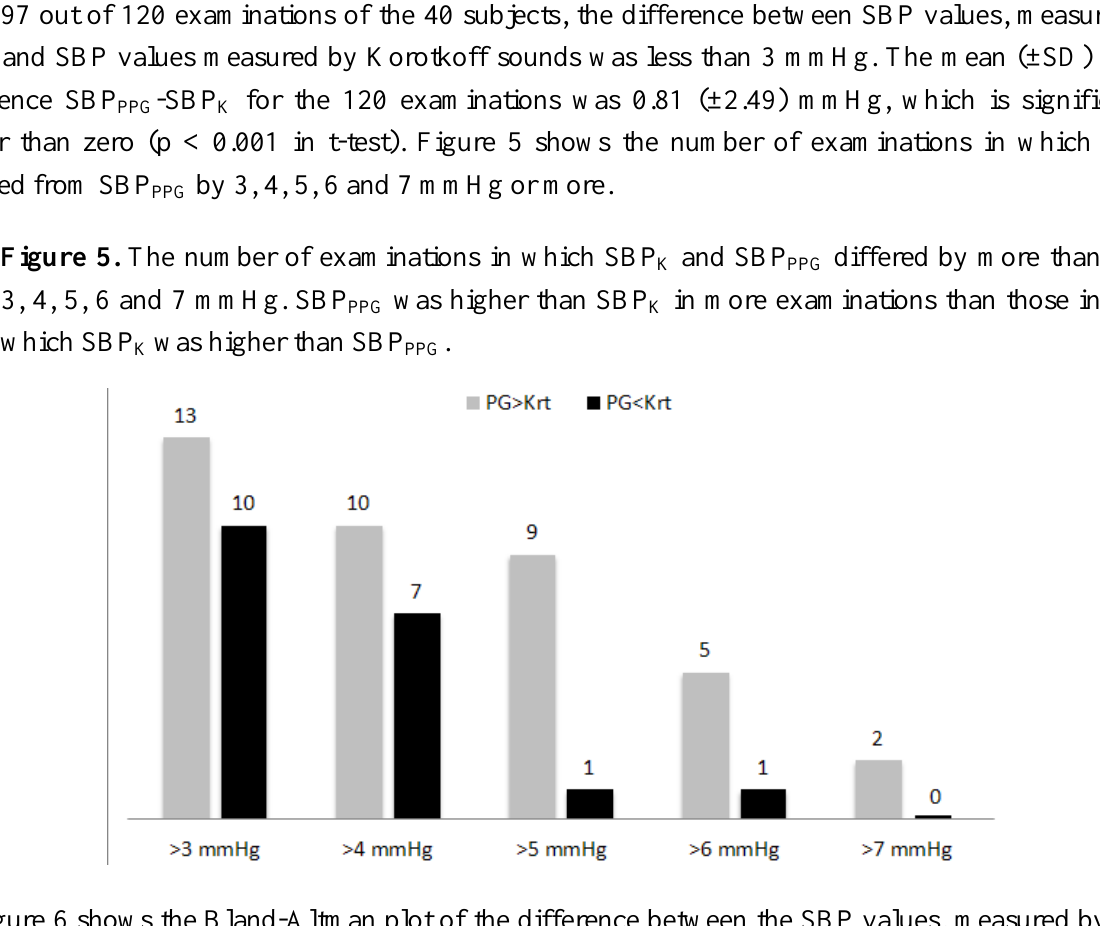
and SBP differed by more than K PPG in more examinations than those in K